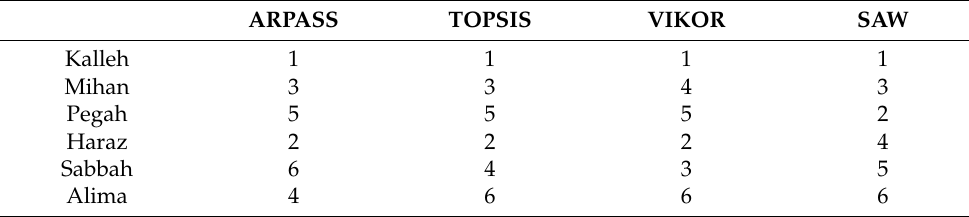
Table 18. The ranking result of the first six suppliers.